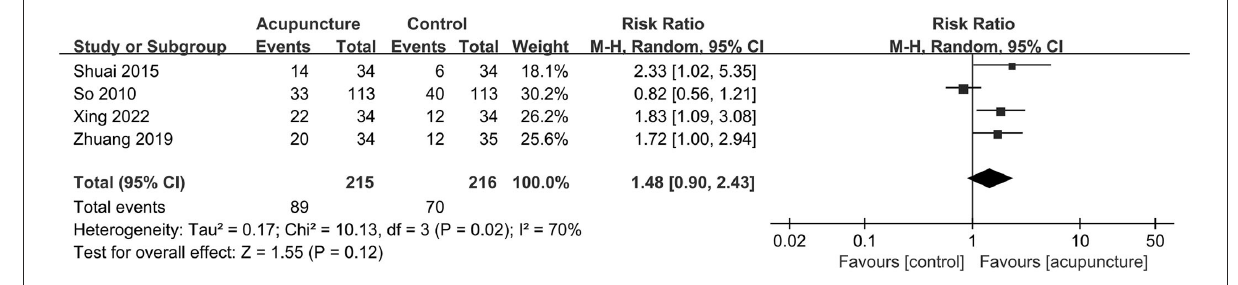
FIGURE5 Forest plot of live birth rate.